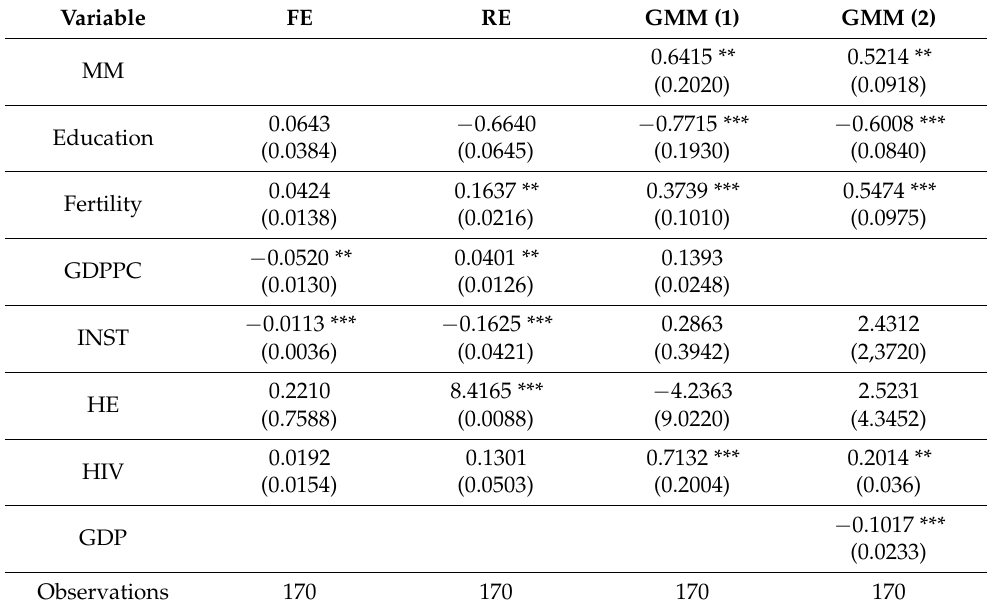
Table 4. Regression results (Dependent variable: